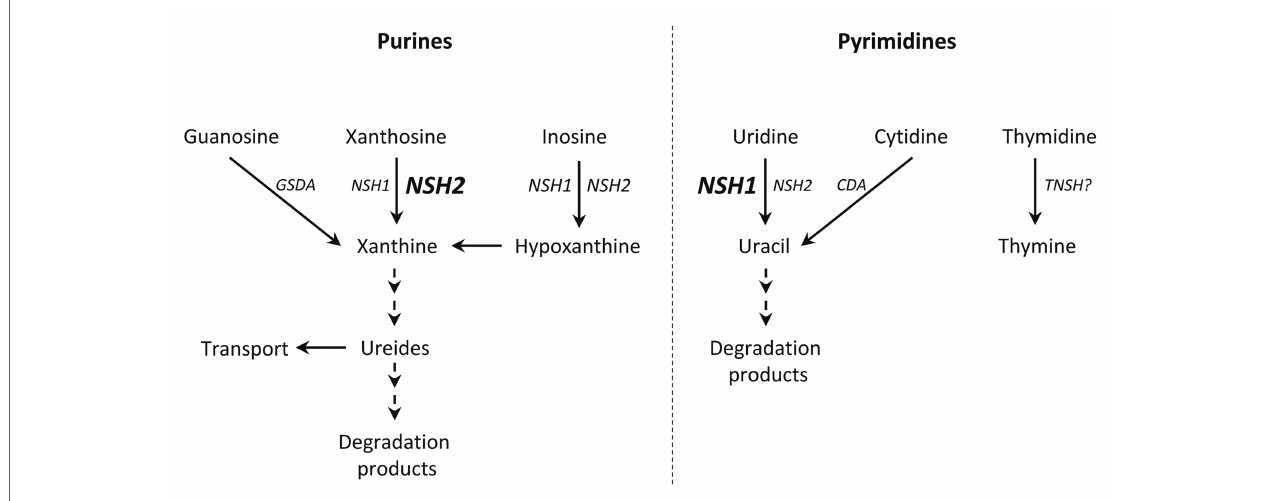
FIGURE 7 | Hypothetical model of purine and pyrimidine degradation during common bean germination highlighting the role of PvNSH1 and PvNSH2. Nucleosidases are induced around radicle emergency. Bold and font size indicated a prominent role of this isoform. (GSDA, guanosine deaminase; CDA, cytidine deaminase; NHS1, PvNSH1; NSH2, PvNSH2; and TNSH, putative thymidine